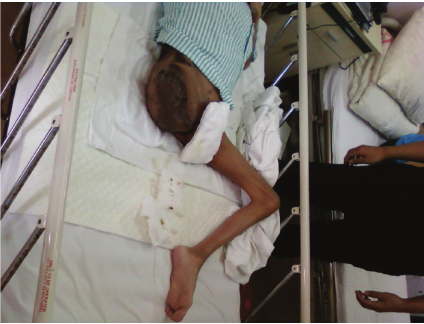
Figure 2: 3 weeks after amputation, the cross-section wound first degree heal.